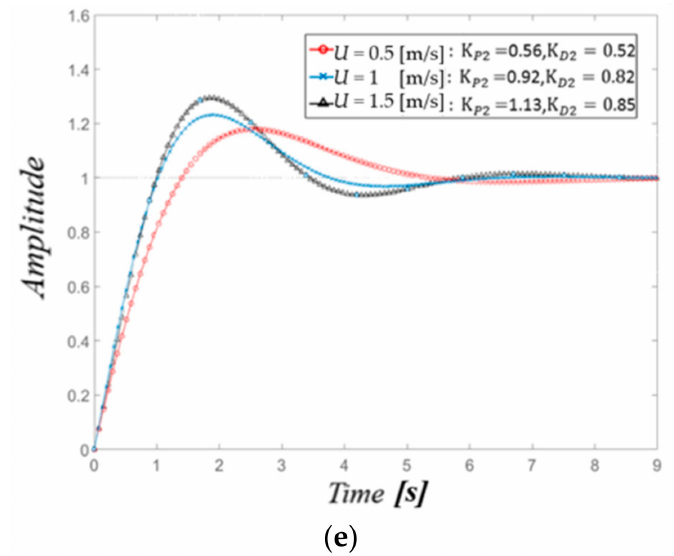
Figure 24. Step responses of the PD controller with respect to three sailing speeds, U = 0.5, 1, and 1.5 m/s, for ( a ) the turning circle test, ( b ) the horizontal zigzag test, ( c ) the spiral test, ( d ) the vertical zigzag test, and ( e ) the meander test. Table 6. The characteristics parameters and the gains of the PD controller with the PID tuner for different manoeuvring tests. Test U [m/s] K P K D Rise Time [s] Settling Time [s] Overshoot [%] Peak 0.5 Turning Circle